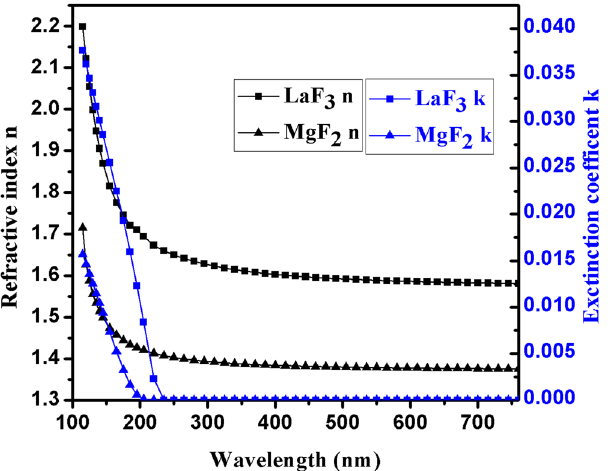
Figure 1. Optical constants of LaF 3 and MgF 2 derived by us from characterization of reflectance (10° and 20°) and transmittance (0°) of a single layer (LaF 3 , MgF 2